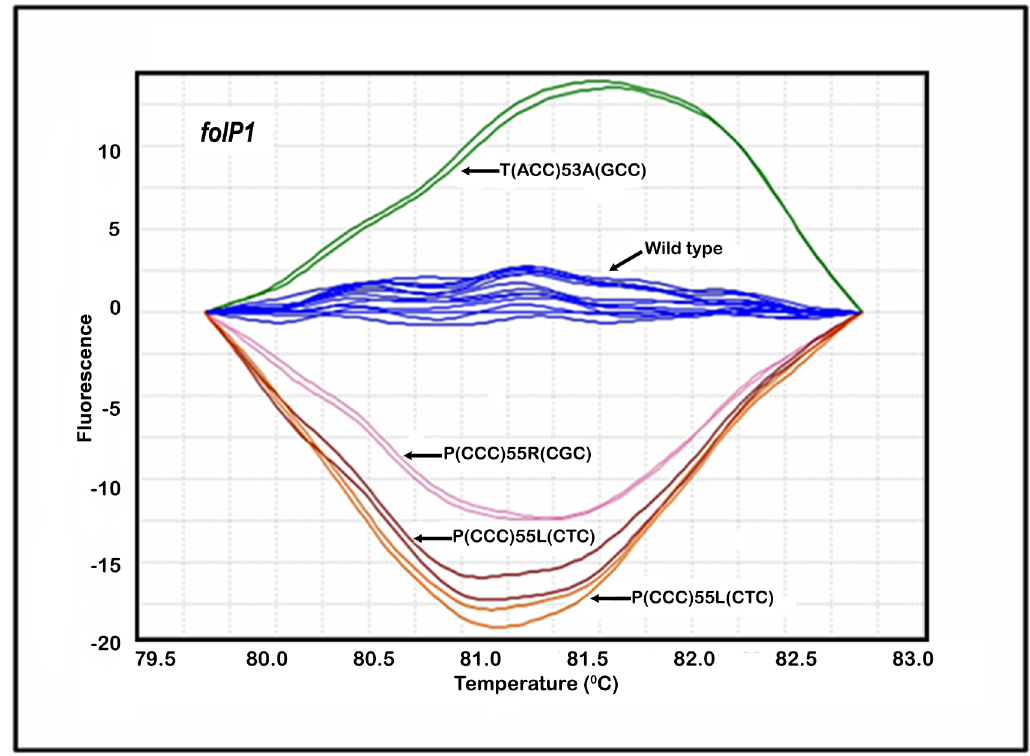
Fig 3. Comparison of M . leprae qPCR-HRM DST difference plot graphic displays of the post-qPCR HRM analysesof the folP1 from clinical strains. DDS-resistantstrains: T(ACC)53A(GCC) = Ref ID# N-33; P(CCC)55R (CGC) = Ref ID# N-08; T(ACC)53I(ATC) = Ref ID# N-30; P(CCC)55L(CTC) = Ref ID# N-21. M . leprae DDS-susceptible strains: Wild-type = Thai-53 (control); Ref ID# B-01; Ref ID# B-08; Ref ID# B-11; Ref ID# B-23; Ref ID# B-32; and Ref ID#